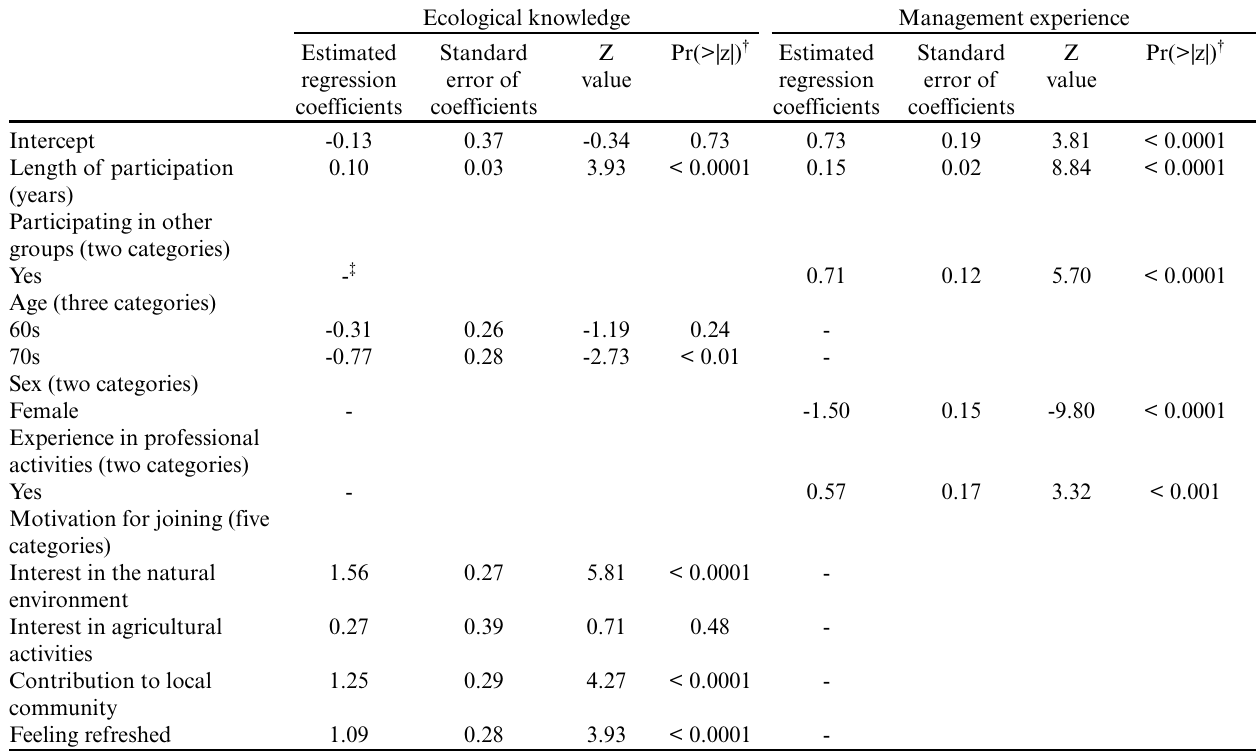
Table 6 . General linear mixed model results for knowledge and experience